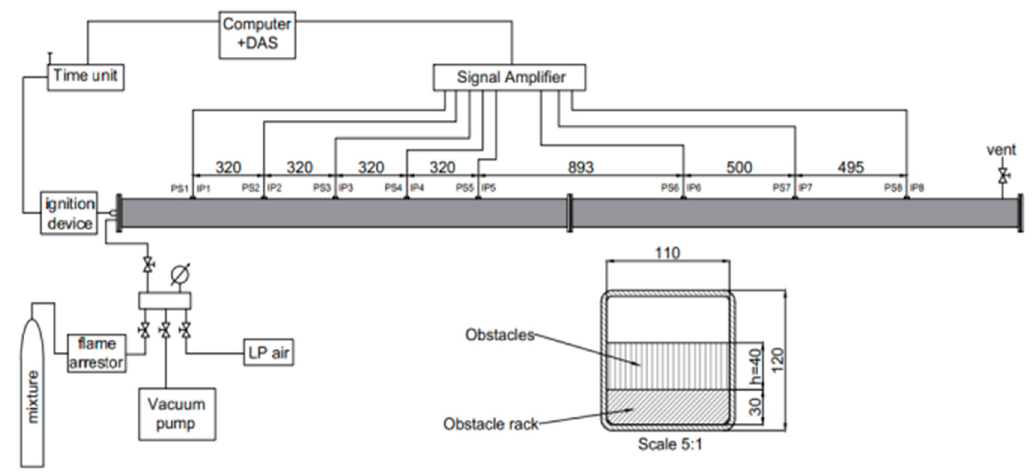
Figure 1. Experimental setup scheme. Setup used for measurements of deflagration to detonation transition process (DDT) limits in H 2 –air mixtures [31]. Distance between pairs of sensors in mm.